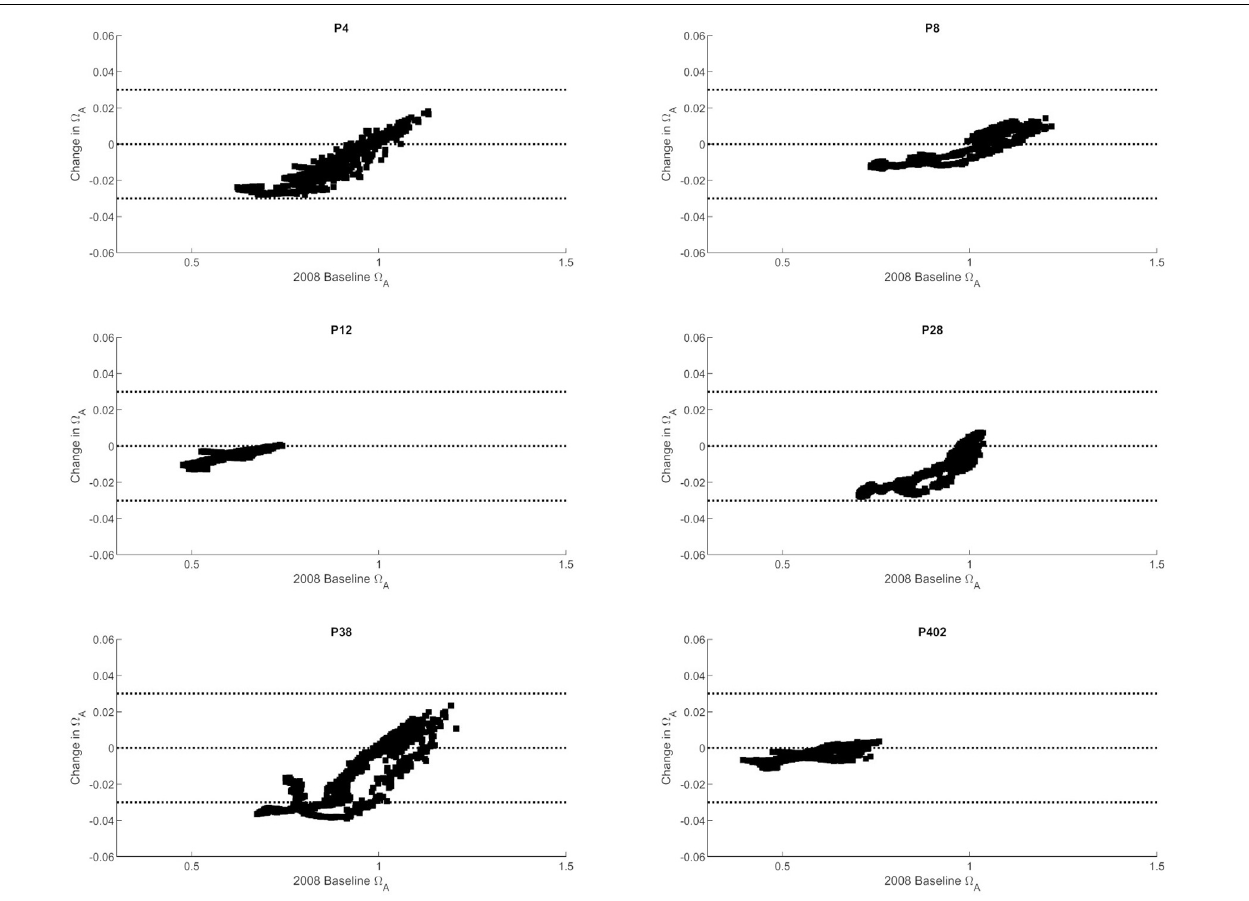
FIGURE 5 | The correlation between baseline (cid:127) ar (as modeled for 2008) and changes in (cid:127) ar at six selected stations in the Puget Sound (P4, P8, P12, P28, P38, P402 with locations shown in Figure 1 ).